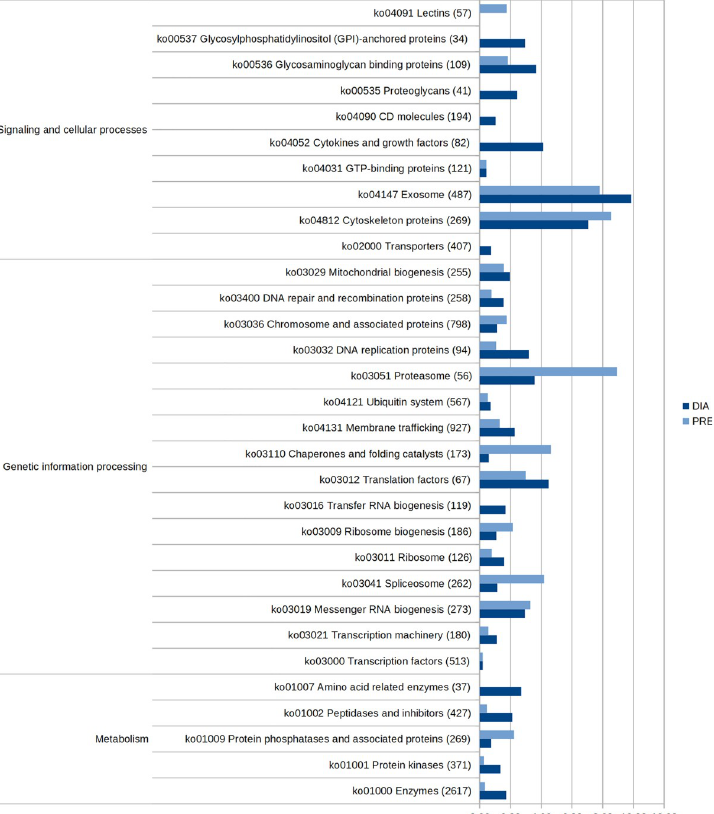
Fig 7. Brite classification of upregulated proteins in prehatching (PRE) and diapause III (DIA). Bars indicate the proportion of proteins upregulated in each condition in relation to the total number of proteins of the entire proteome assigned to each category (PRE: light blue, DIA: blue). On the left side, the upper hierarchical category is shown.